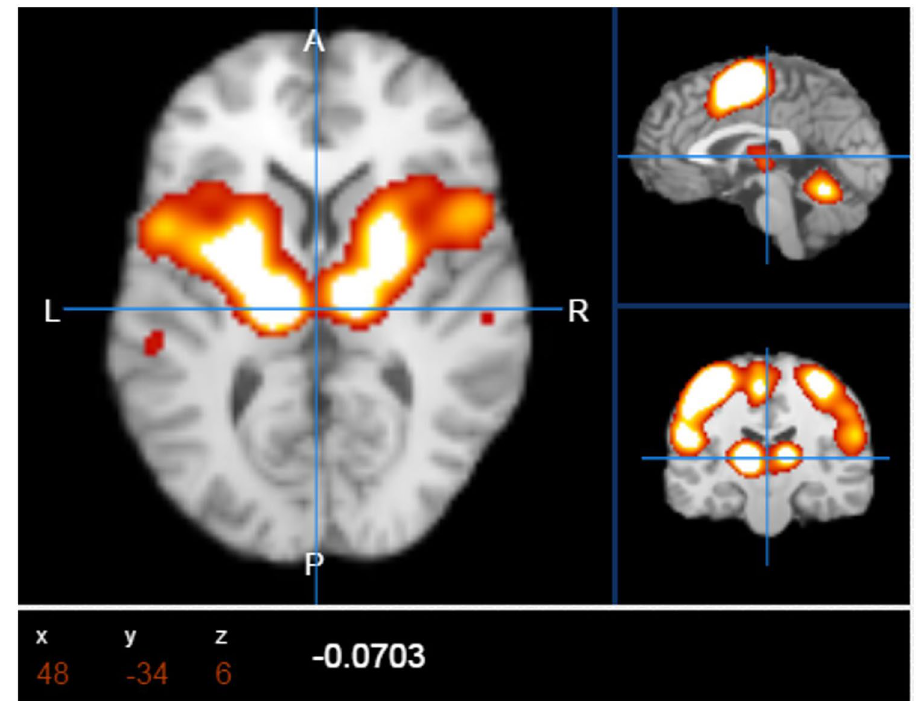
Figure 2. Main brain activation points for Action–Execution, archived in the BrainMap.org database. The activation points confirmed by many experimental fMRI studies are